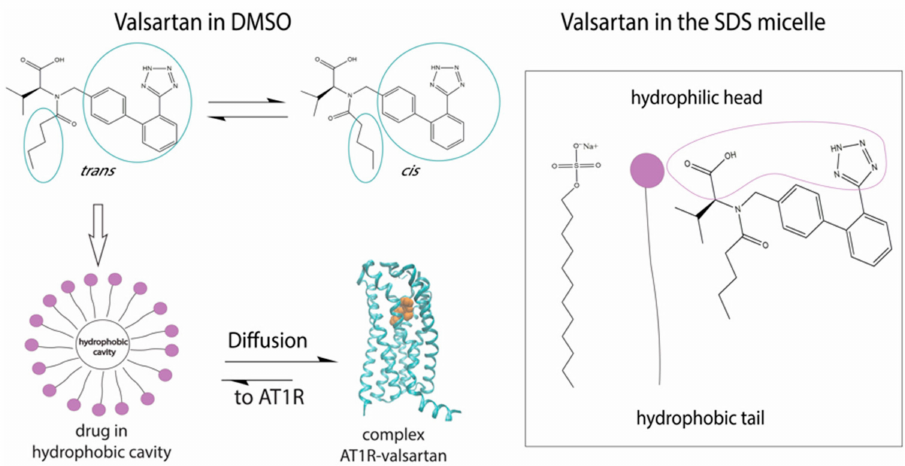
Figure 2. Mechanism of action of valsartan. The trans conformation of the drug is firstly encapsulated in the micelle and then diffused towards